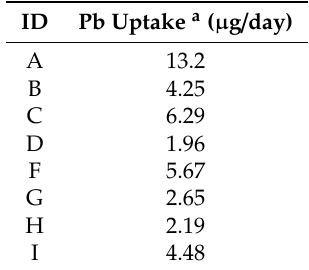
Table 2. Estimated Pb uptake calculated from blood Pb